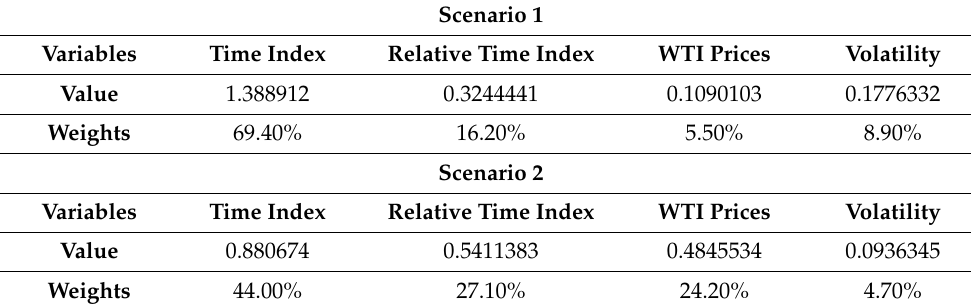
Figure 6. Encoder-based results for Variable Importance. Table 5. Variables